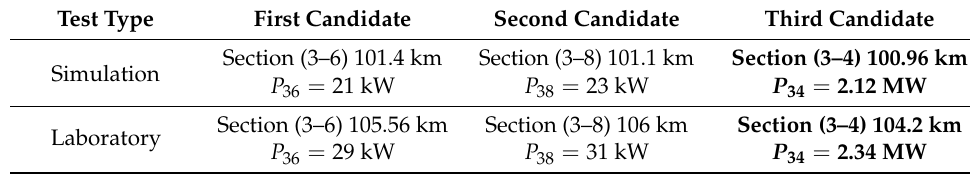
Figure 8. Single line diagram of the laboratory test network.